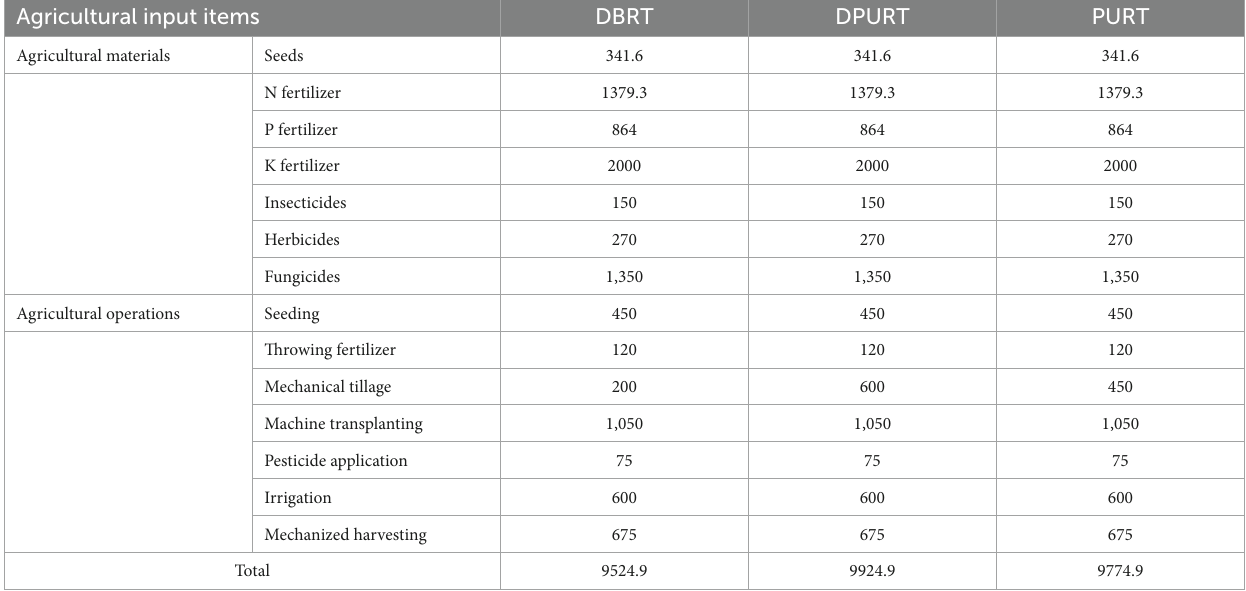
TABLE 9 Costs (CNY ha − 1 ) of agricultural materials and operations in the three tillage treatments in 2021 and 2022. Agricultural input items